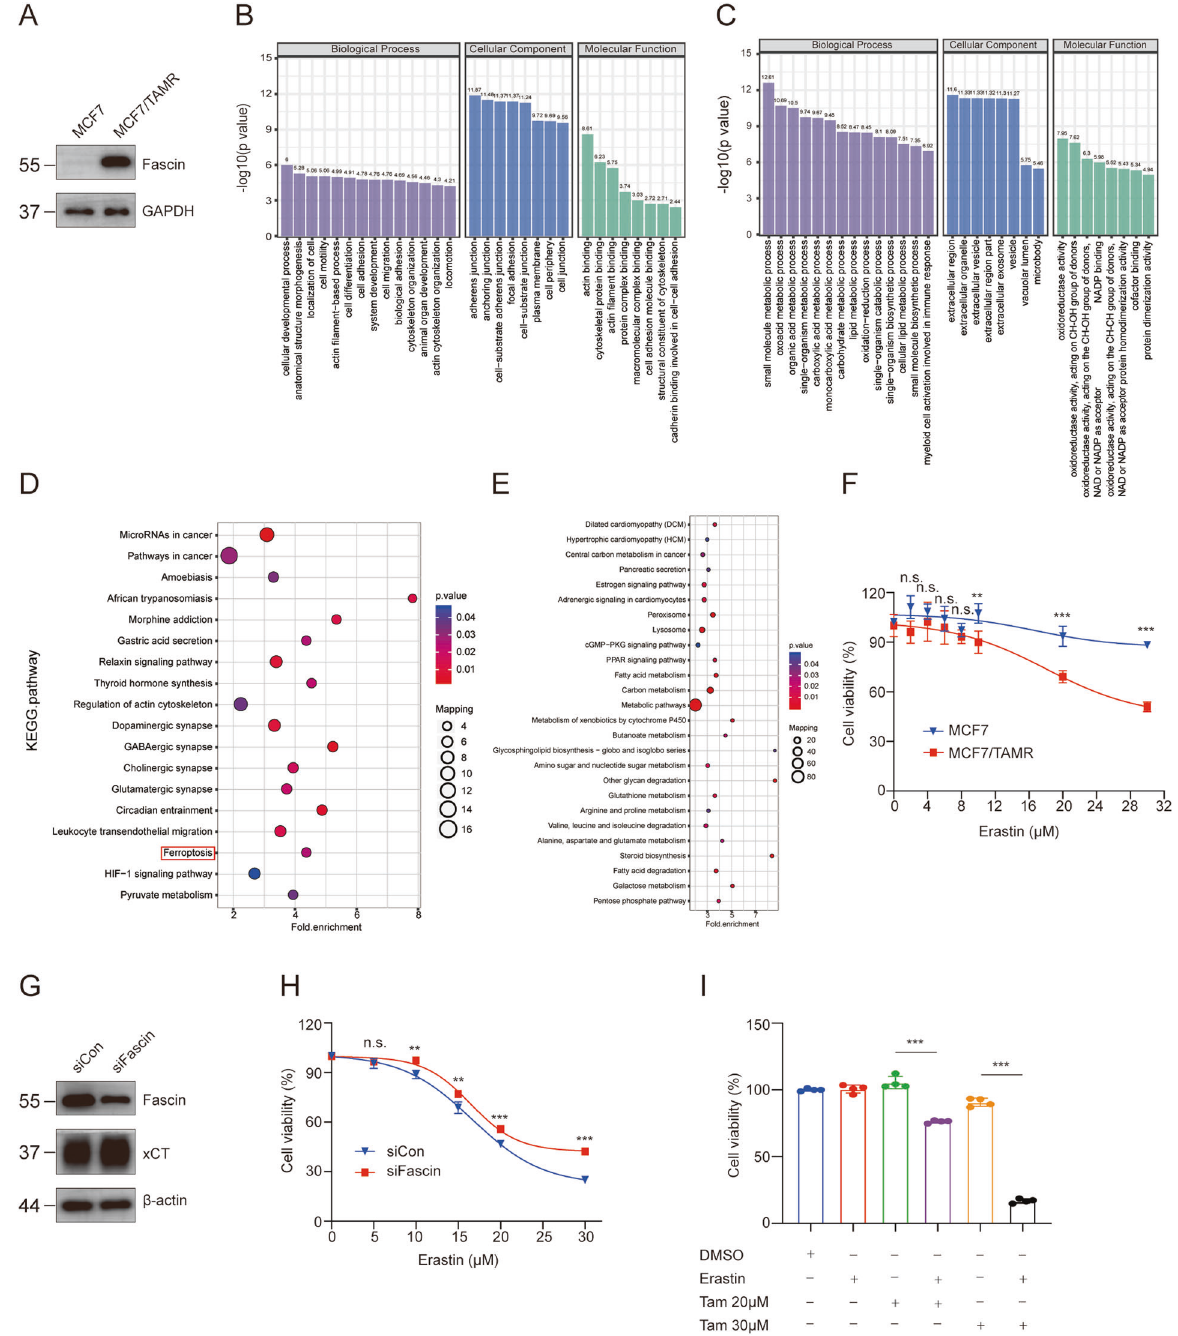
Fig. 7 Ferroptosis induction as a novel treatment to suppress tamoxifen-resistant cells. A Relative Fascin status in wild-type MCF7 and tamoxifen-resistant MCF7/TAMR cells. B – E A total of 664 differentially expressed proteins were analyzed for GO annotations and KEGG enrichments. A total of 255 upregulated proteins were analyzed for GO annotations ( B ) and KEGG enrichments ( D ). A total of 409 downregulated proteins were analyzed for GO annotations ( C ) and KEGG enrichments ( E ). F MCF7 and MCF7/TAMR cells were incubated with the indicated concentrations of erastin for 48 h and then assayed for cell viability. G Western blot analysis showing that Fascin knockdown increases xCT levels in MCF7/TAMR cells. Cell lysates were collected after 72 h transfection. H MCF7/TAMR cells transfected with Fascin siRNAs or siCon were incubated with the indicated concentrations of erastin for 48 h and then assayed for cell viability. I MCF7/TAMR cells were incubated for 48 h with or without 20 or 30 μ M 4-OH tamoxifen and in the absence or presence of 5 μ M erastin. n.s. not signi fi cant. ** p < 0.01, and *** p < 0.001. The data are displayed as the means ± s.d of three independent